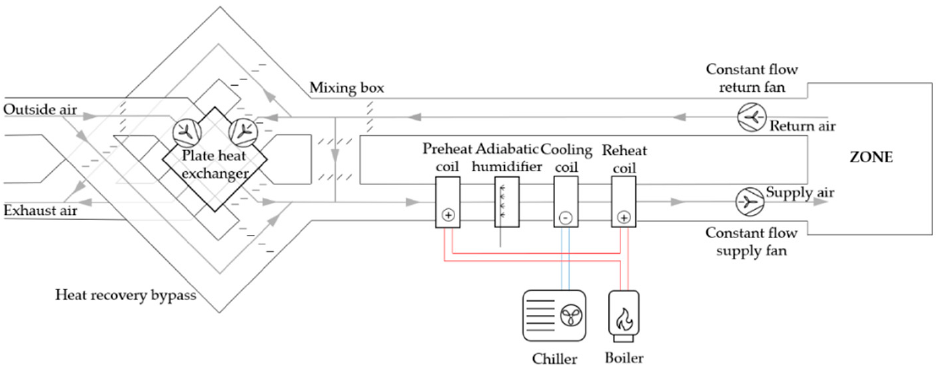
Figure 2. HVAC system layout.